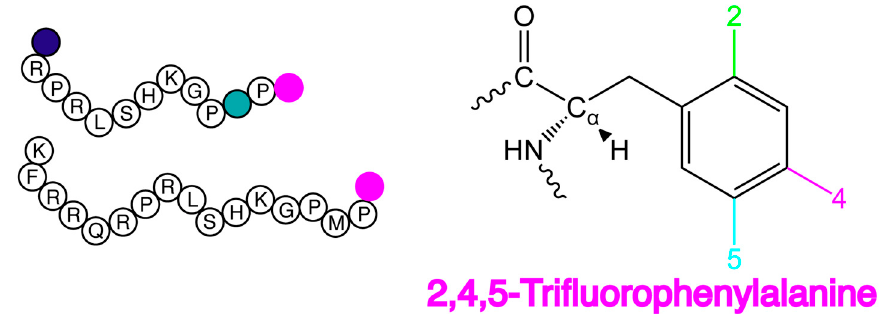
Figure 1. Amino acid sequence of F*-ap-13 (top) and F*-ap-17 (bottom), with the trifluorophenylalanine (right). Colored boxes indicate the non-standard amino acids pyroglutamate (blue), norleucine (teal) and the 2,4,5-trifluorophenylalanine label (pink).